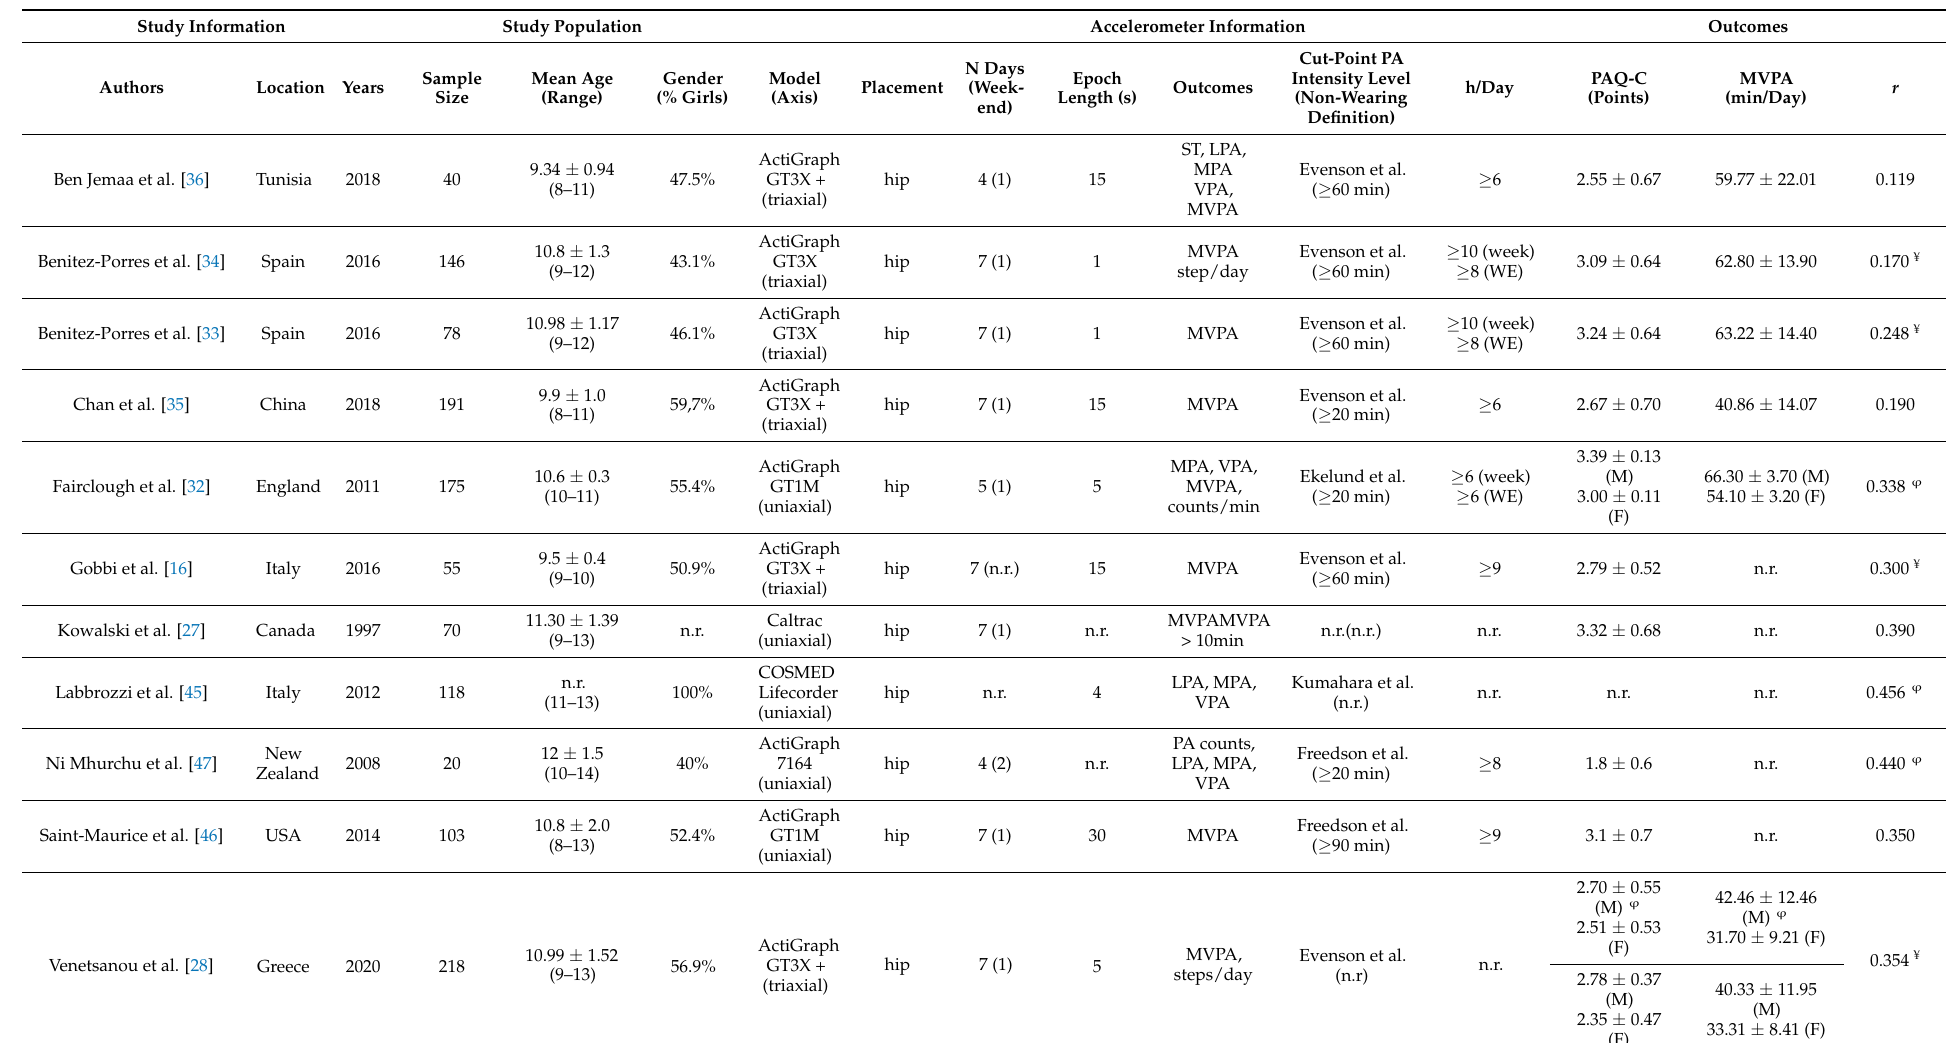
Table 1. Summary of the studies included in the meta-analysis (alphabetical